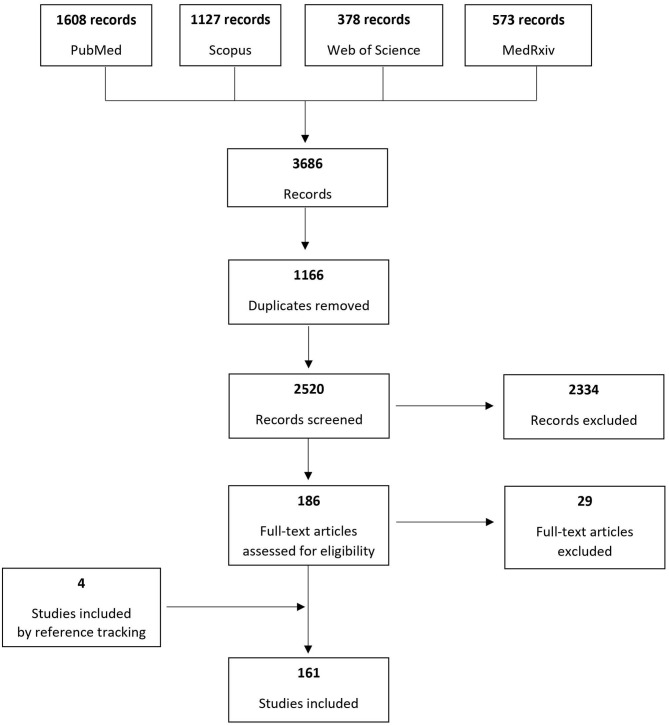
Systematic review flowchart.